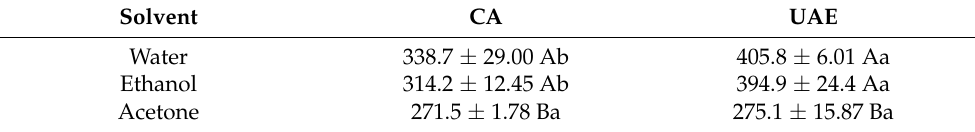
GAE, gallic acid equivalent; FW, fresh weight. Results are expressed as mean (n = 3) ± standard deviation (SD). Results followed by the same lowercase letter in the row and the same uppercase letter in the column do not differ significantly (Tukey’s test, p <